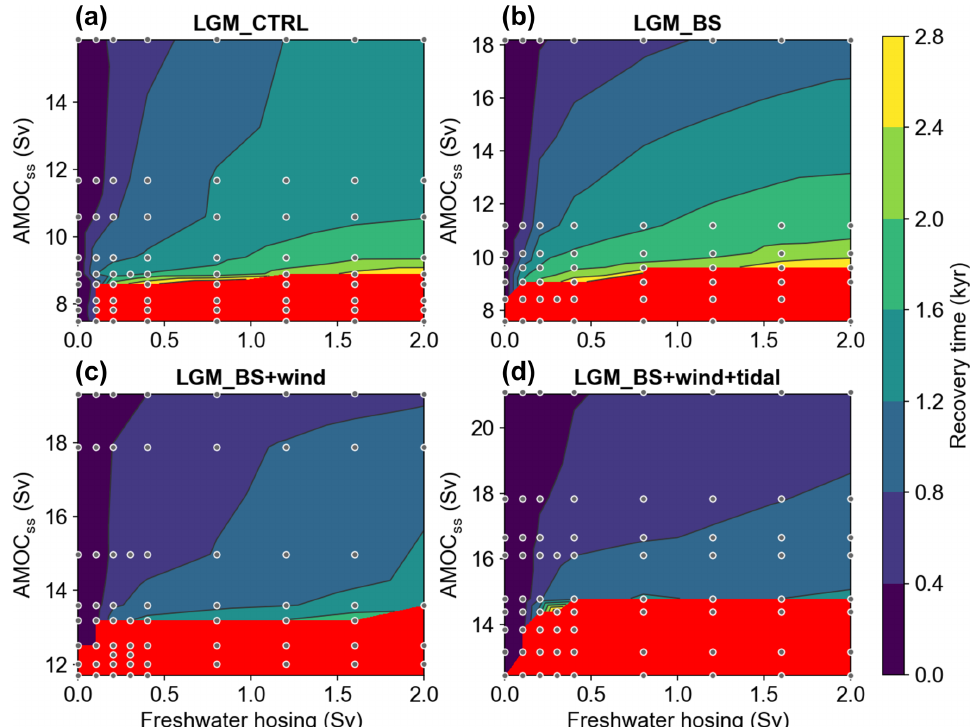
Figure 7. Dependency of AMOC recovery time on steady-state circulation strength (AMOC ss ) and freshwater hosing amplitude. Model configurations of (a) LGM_CTRL, (b) LGM_BS, (c) LGM_BS + wind, and (d) LGM_BS + wind + tidal. The simulations are indicated by gray dots. The AMOC was weakened by applying a continuous freshwater transfer flux from the North Pacific to the North Atlantic that shifts the steady state into a new equilibrium (same as for Fig. 6). Freshwater hosing applied to the North Atlantic (45–70 ◦ N) lasted for 500 years. The recovery time was calculated as the time after the hosing until the steady-state AMOC strength was reached again. Red areas mark simulations where the AMOC remained in the collapsed state after the freshwater perturbation with no indication of recovery. Note the different scales on the y axes.